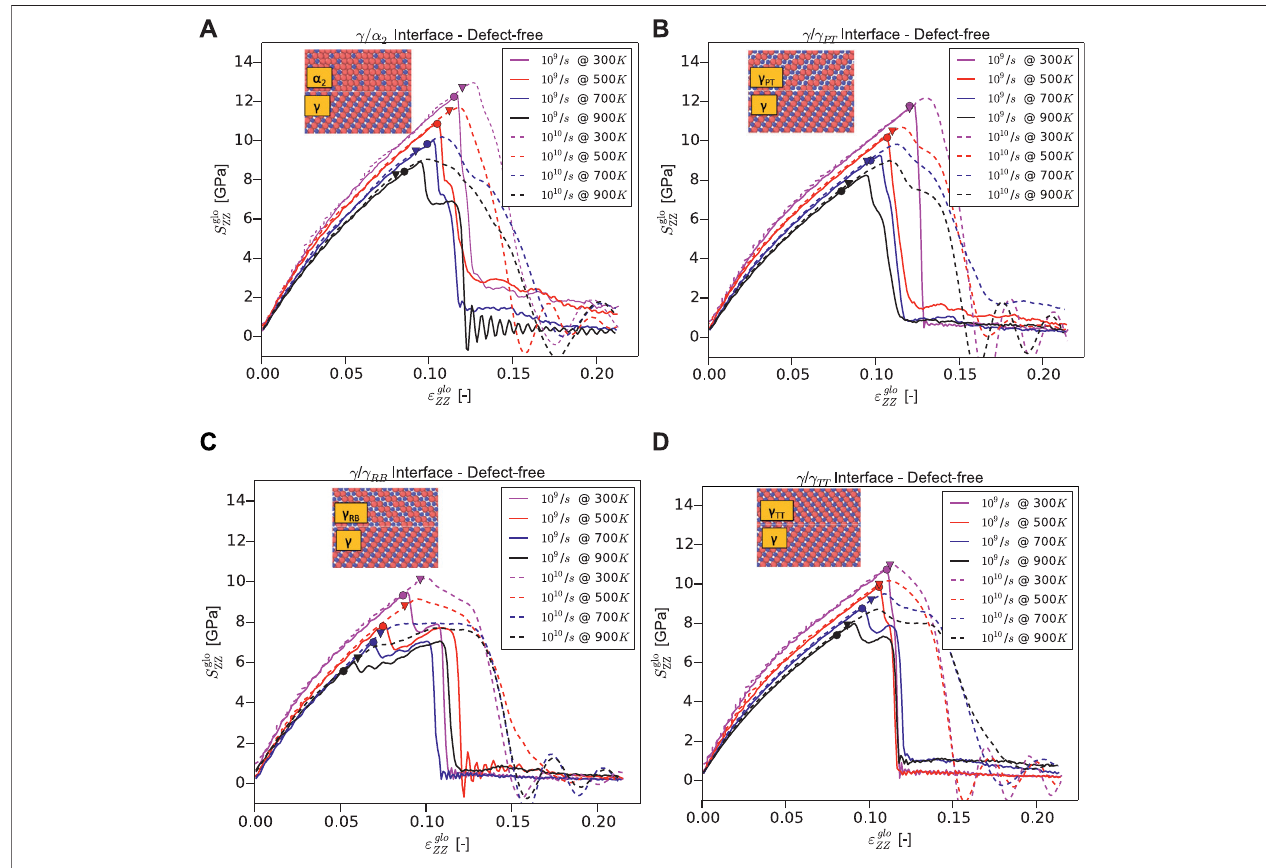
FIGURE 4 | Stress – strain curves under normal loading for Type-1 models of (A) c / α 2 , (B) c / c PT , (C) c / c RB , and (D) c / c TT interfaces for different temperatures and strain rates. Here, the inset shows the section of the corresponding interfaces normal to the close-packed direction. The solid circle and triangle markers represent the dislocation nucleation point for the strain rates _ ε glo ZZ (cid:2) 10 9 / s (solid lines, circles) and _ ε glo ZZ (cid:2) 10 10 / s (dashed lines, triangles).